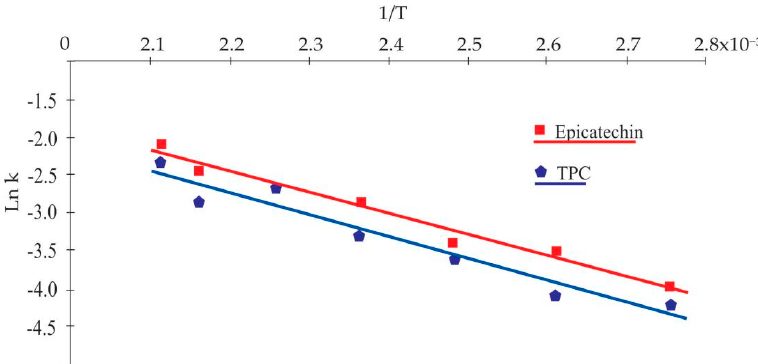
Figure 2. Correlation of Ln 𝑘 with 1/T to obtain the TPC and epicatechin kinetic